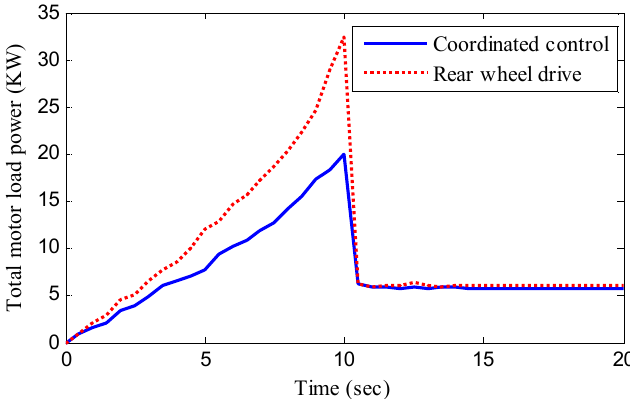
Figure 11. Total motor load power in case study 1.